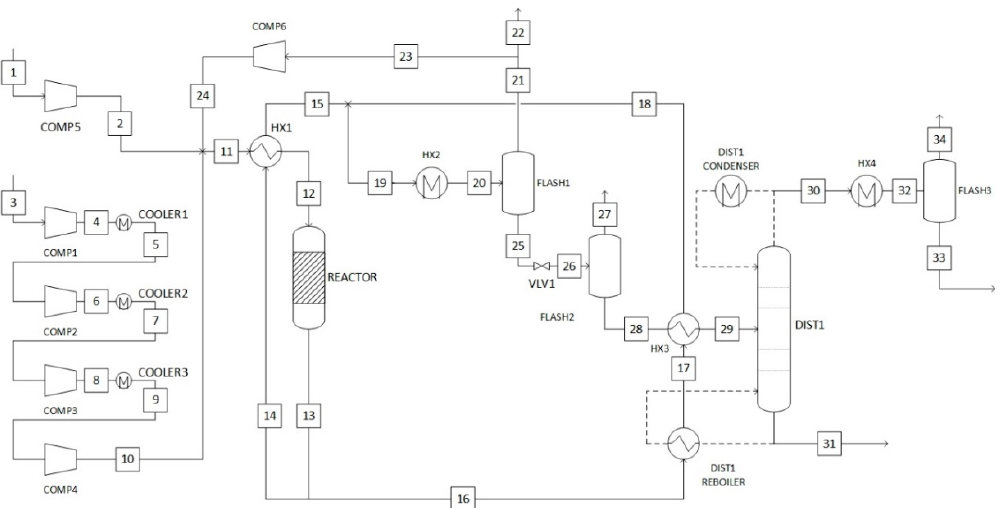
Figure 2. Flowsheet of the gas-phase CO 2 hydrogenation to methanol process. The corresponding stream table is presented in Table S1 (Supplementary Material). Inlet and outlet streams: 1. Hydrogen inlet, 3. CO 2 inlet, 22. purge from gas recycle, 27. gas purge from second flash tank, 31. waste water outlet, 33. methanol product outlet, 34. gas purge from final flash tank. COMP, compression stage; HX, heat exchanger; DIST, distillation